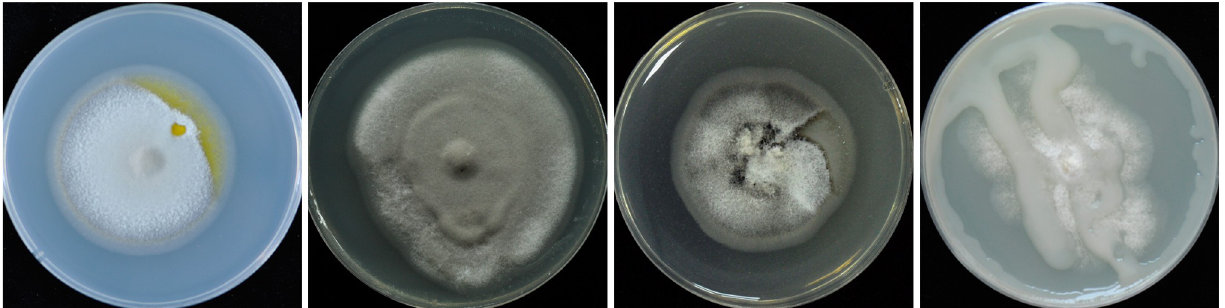
Fig 2. Experimental procedure of CS